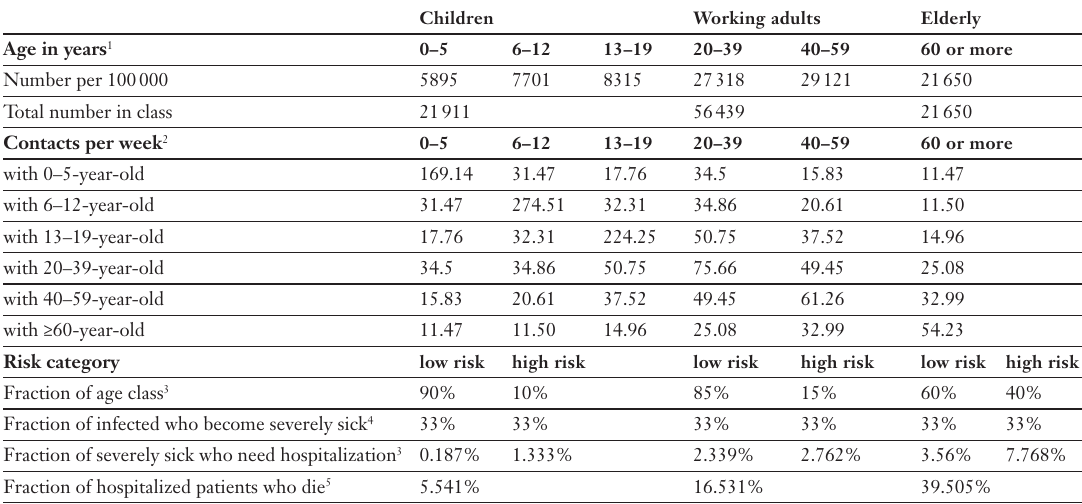
Fraction of severely sick who need hospitalization 3